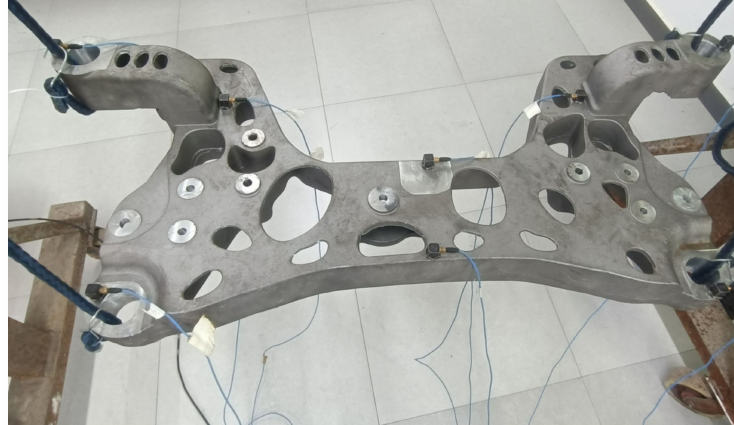
Figure 24. Free modal test platform of aluminium alloy subframe.